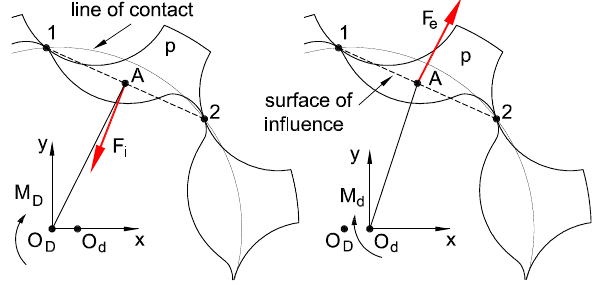
Figure 15. Torque method for the determination of the volume derivative.